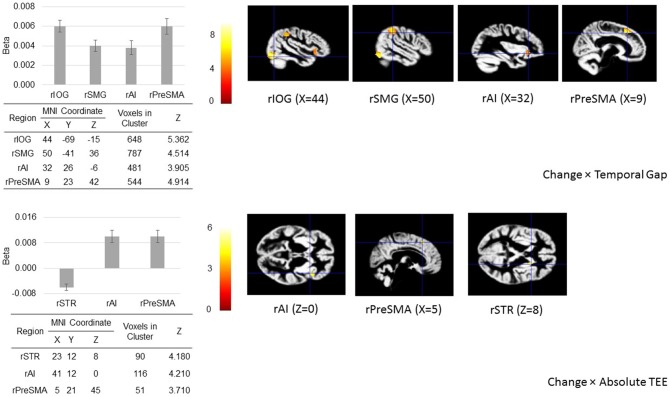
Regions of interest (ROIs) analysis. When action update was demanded (in the change-task condition), temporal gaps and absolute TEEs produced changes in the hemodynamic response of our a priori defined ROIs located in sensory (right inferior occipital gyrus, rIOG), associative (right supramarginal gyrus, rSMG), frontal (right presupplementary motor area, rPreSMA; right anterior insula, rAI), and striatal areas (right striatum, rSTR) associated with both sensorimotor integration and response inhibition. The figure shows regional peak activities overlaid on the group-specific anatomical template.